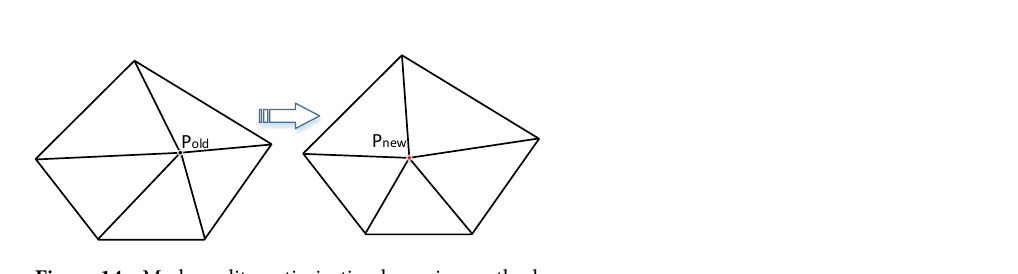
Figure 14. Mesh quality optimization by spring